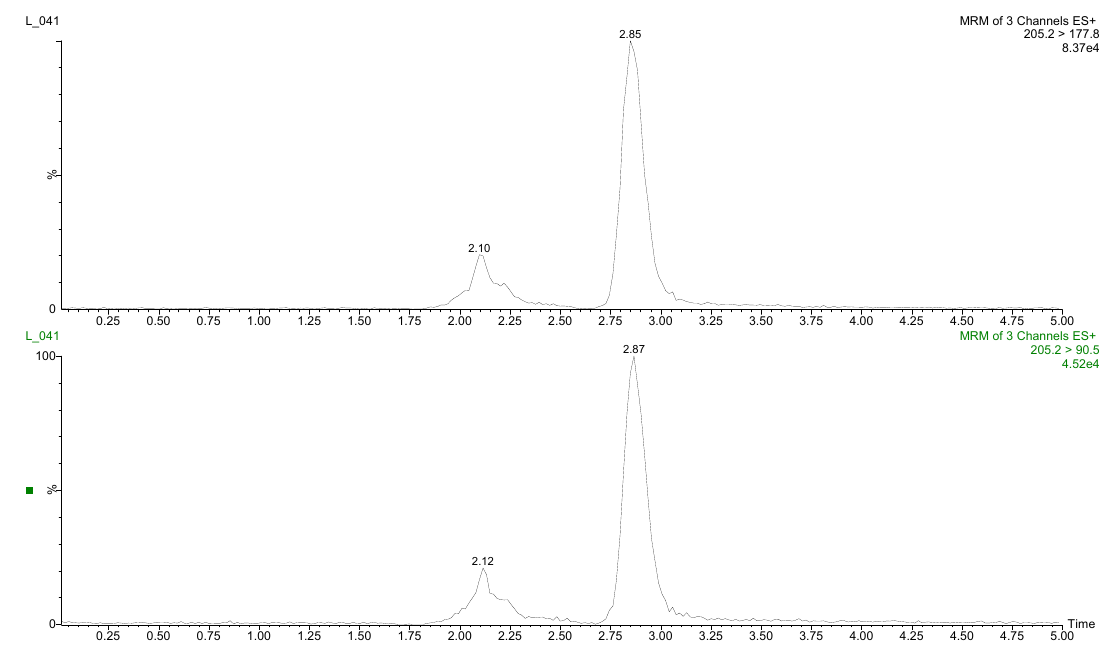
Figure A8. Chromatogram of the treated chicken kidney sample 24 h after treatment.